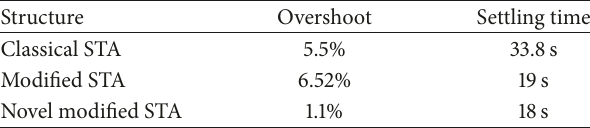
Table 1: The performances of the different structures of